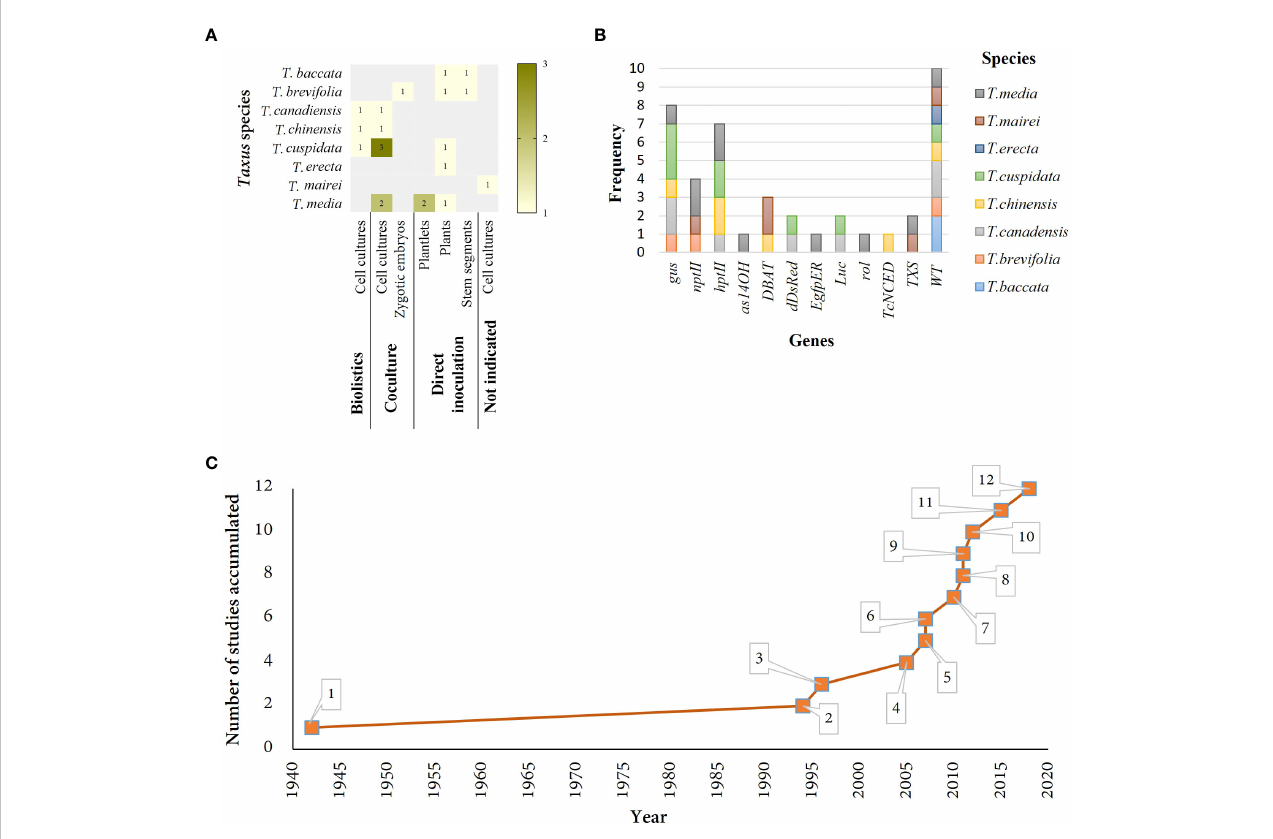
FIGURE 1 Summary of studies related to Taxus cell cultures. (A) Studies in different Taxus species grouped by genetic transformation technique and plant material used. (B) Frequency of exogenous genes used across different species of taxus. (C) Number of studies accumulated in Taxus cell cultures through time. 1. Direct inoculation of plants resulted in crown galls (Smith, 1942). 2. Direct inoculation of stem segments resulted in crown galls (Han et al., 1994). 3. GUS activity was observed after coculture of plasmid and Zygotic embryos (Luan et al., 1996). 4. Stable cell line overexpressing S-DBAT gene (Ho et al., 2005). 5. Stable transformants after infection with Agrobacterium (Ketchum et al., 2007). 6. Transient transformation achieved with biolistic on cell cultures. Elicitation experiments tested. (Vongpaseuth et al., 2007). 7. Higher production of PTX in cell lines with rol genes, overexpressing TXS gene (Exposito et al., 2010). 8. Stable cell line overexpressing DBAT gene (Zhang et al., 2011b). 9. Decreased of C14OH taxanes on transgenic cell lines overexpressing as14OH gene (Li et al., 2011). 10. Cell lines overexpressing TcNCED gene and transformed by biolistic showed higher levels of ABA and PTX (Li et al., 2012). 11. The highest transformation ef fi ciency (75%) achieved in T. x media cell cultures (Mart ı ́ nez-Ma ́ rquez et al., 2015). 12. Identi fi cation of best Agrobacterium strain for cell transformation of T.cuspidata and T. canadensis (Wilson et al.,